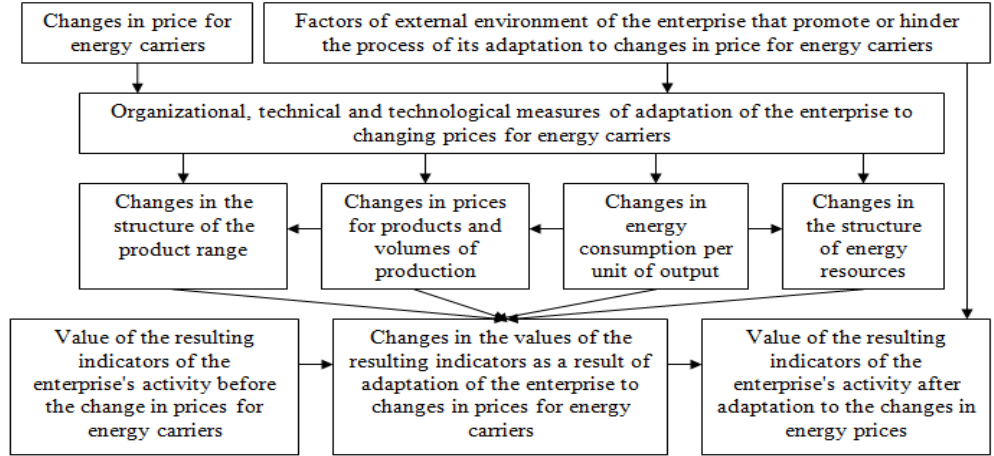
Figure 1. The general model of enterprise adaptation to changes in prices for energy carriers.